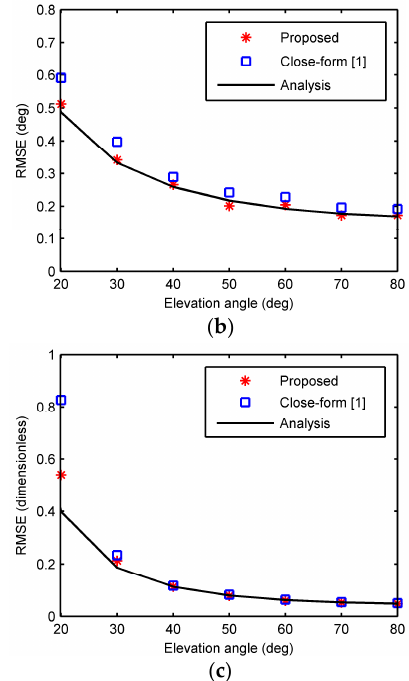
Figure 4. RMSE against elevation angles. ( a ) The elevation angle; ( b ) the azimuth angle; ( c ) the range.